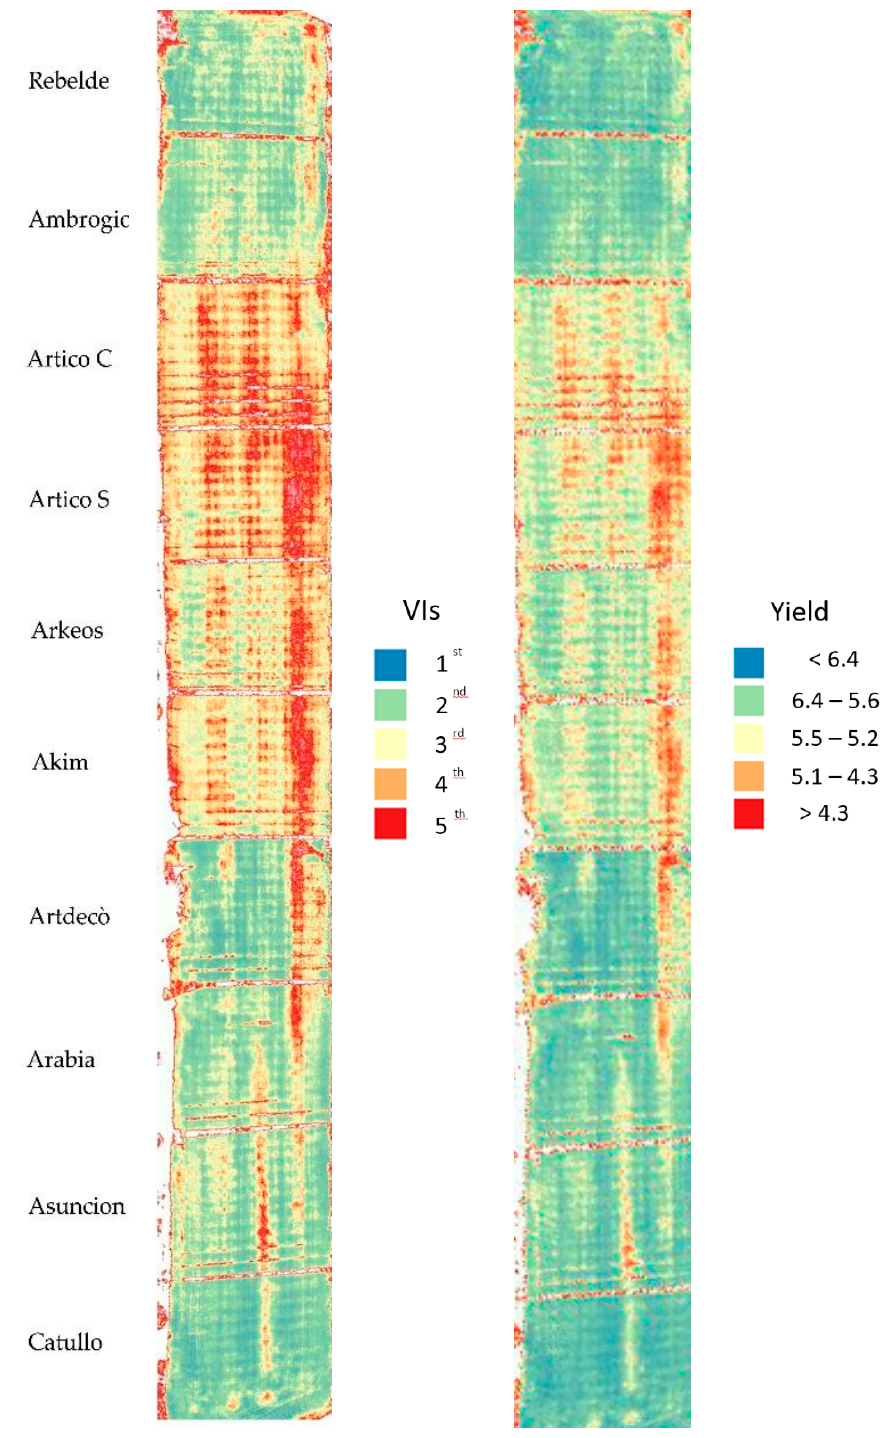
Figure 4. Map of the VIs spatial variability of the ten cultivars clustered by Ward’s method (sx). Map of the yield spatial variability elaborated by the combination of VIs data and ground truth data according to the regression reported in Appendix B (dx).